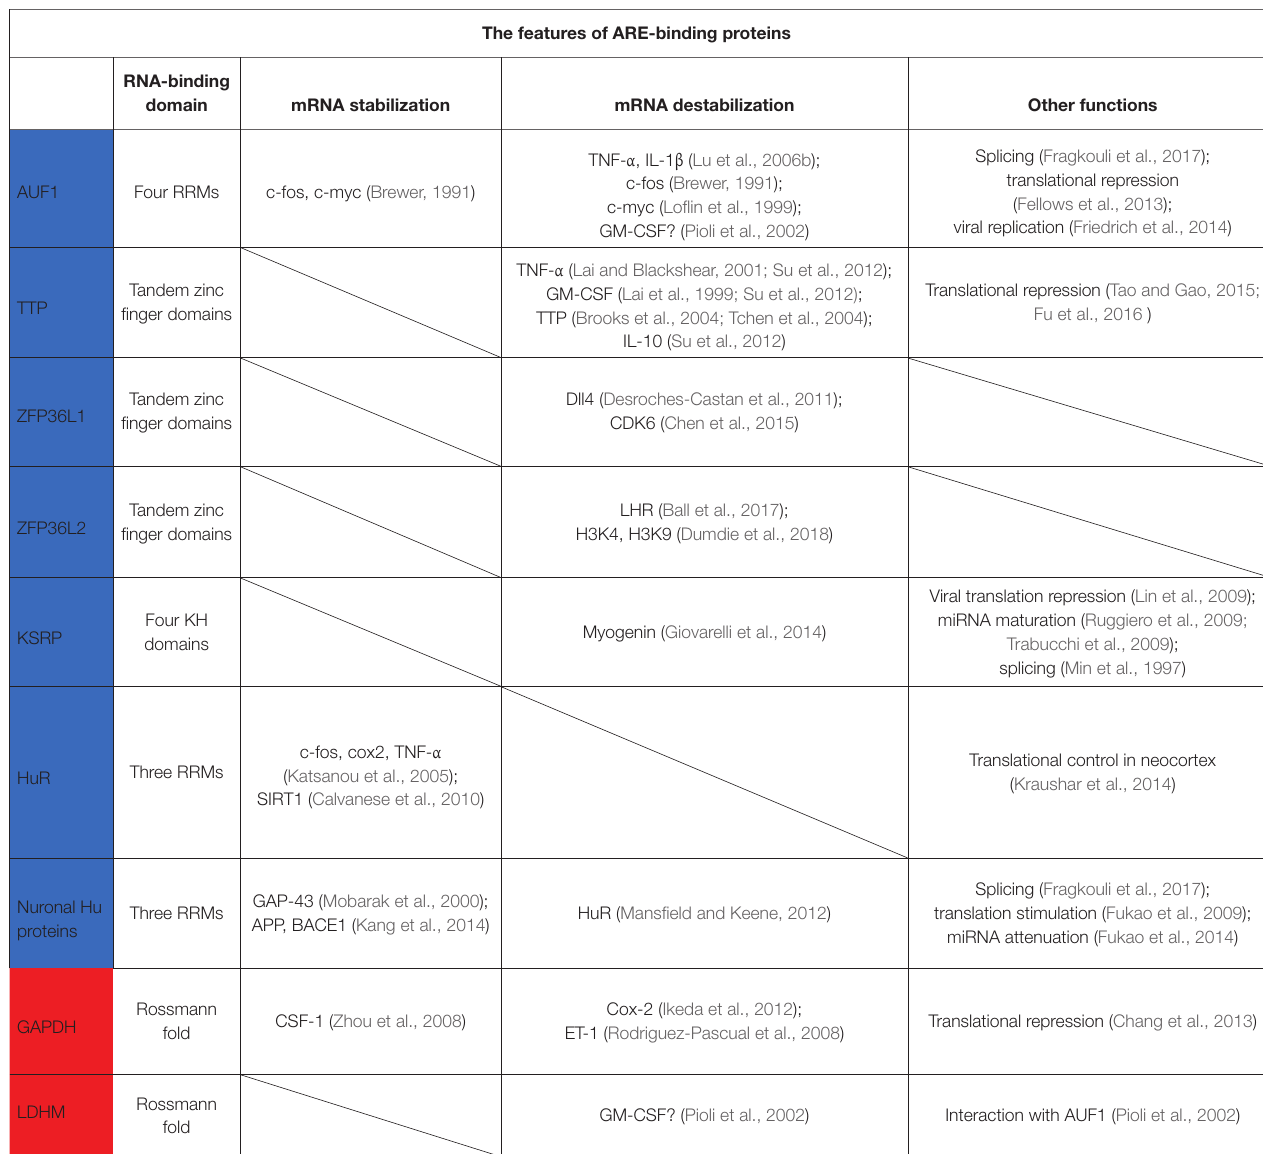
The features of ARE-binding proteins